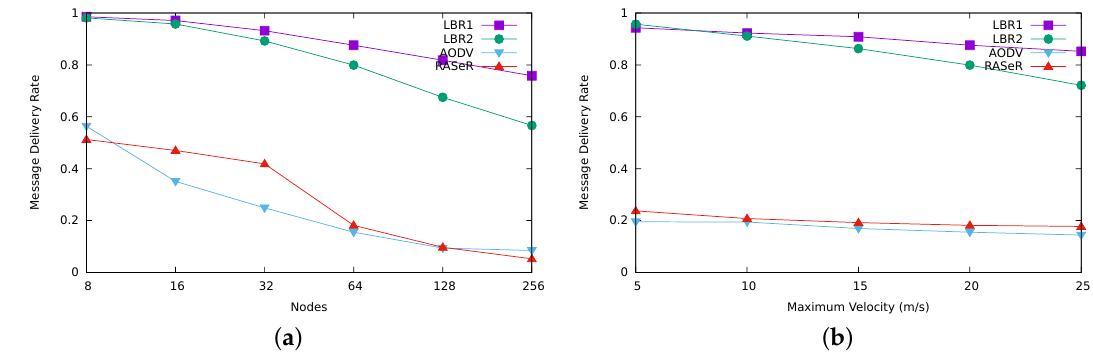
Figure 4. Comparative results for the delivery rate. ( a ) delivery rate regarding scalability; ( b ) delivery rate regarding mobility.